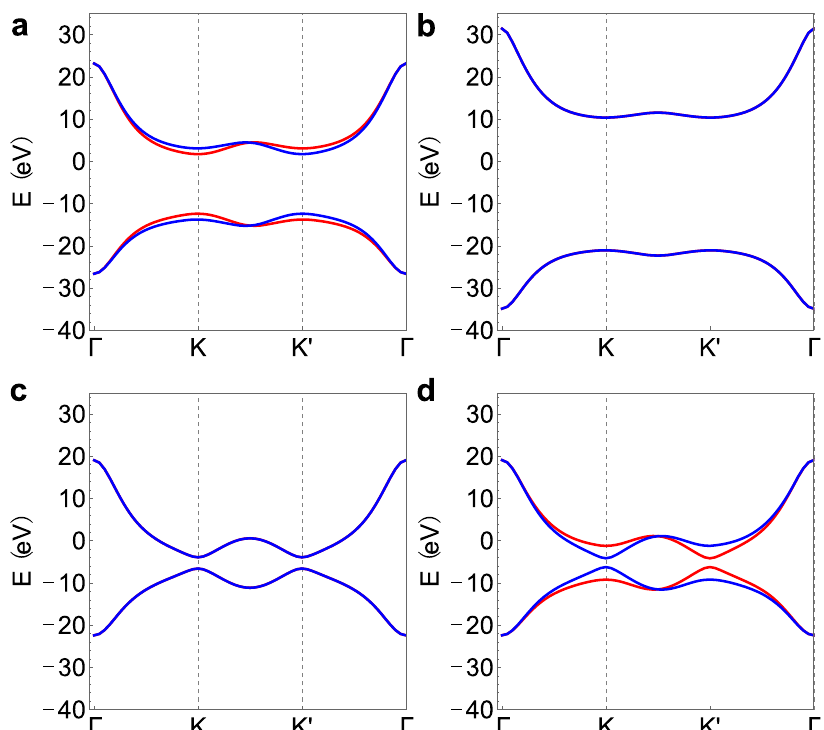
Fig. 5 The effective mass term. Band structure of pristine TBG with different mass terms. a Δ b = 30 meV and Δ t = 0, b Δ b = Δ t = 30 meV, c Δ b = − Δ t = 30 meV and d Δ b = 30 meV and Δ t = − 40 meV. In each panel, blue and red lines are the bands corresponding to each valley. The periodic potentials are set to